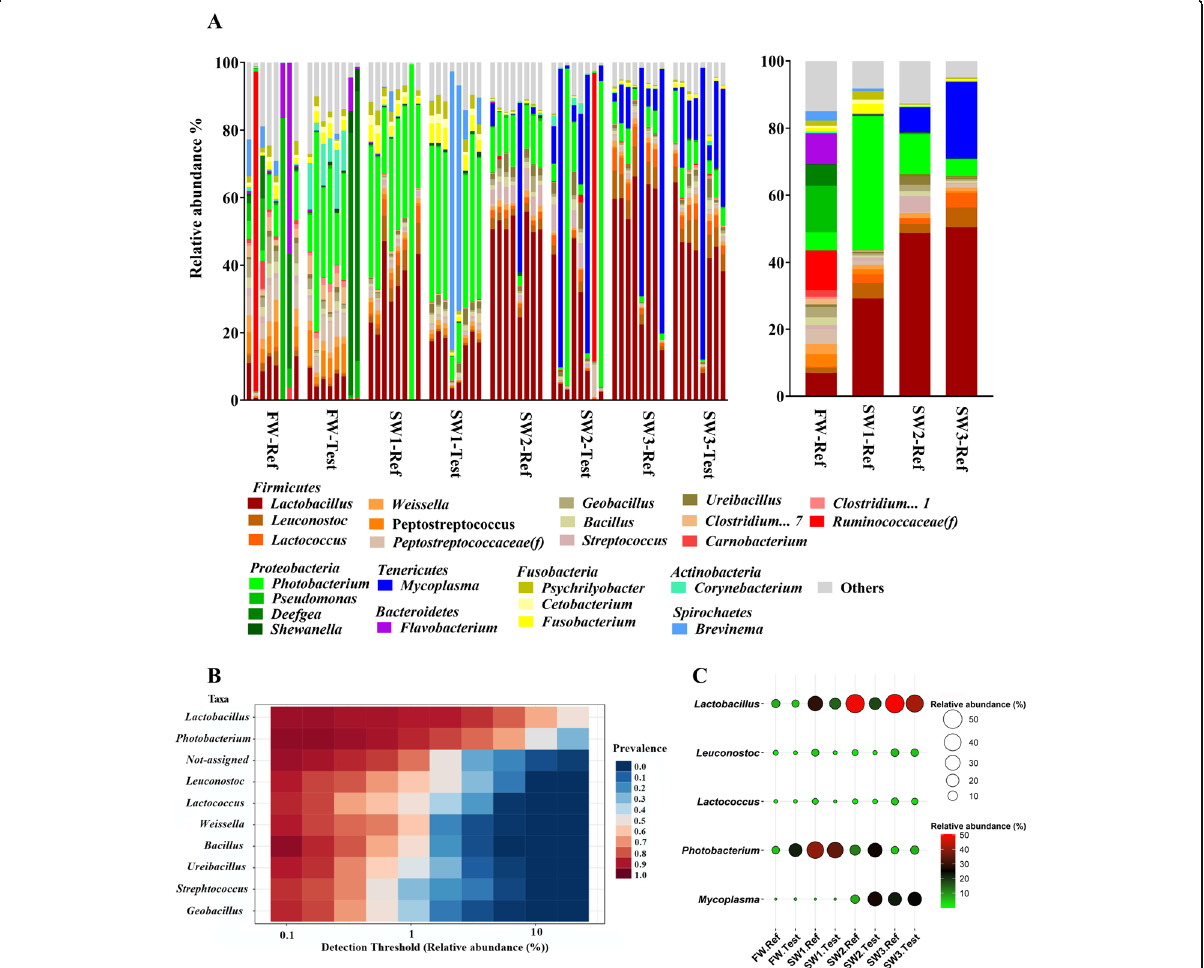
Fig. 2 Digesta-associated distal intestinal microbiota composition of Atlantic salmon. a Top 25 most abundant taxa at genus level of all samples and mean (right side) relative abundance of each taxon between fish fed Ref diet among sampling time points. The top 25 genera were selected accounted for more than 80% of the total abundance in each treatment. f__, family. b The core microbiota between samples at genus level. The figures showing the bacteria were selected above 0.1% relative abundance in 80% of samples. c Balloon plot showing the relative abundance of five major genera between treatments ( n = 8). The five major genera were selected based on MaAsLin 2 and core microbiota